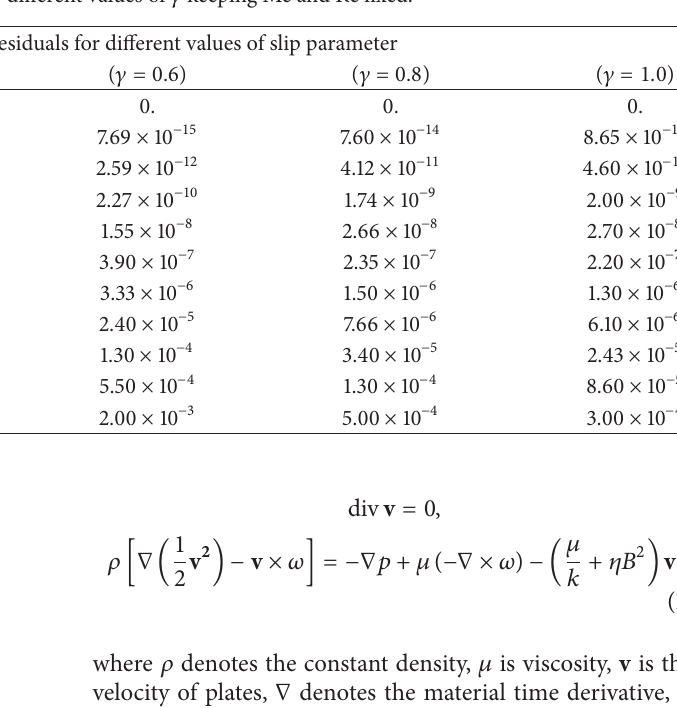
Table 1: Absolute residuals for different values of 𝛾 keeping Me and Re fixed.